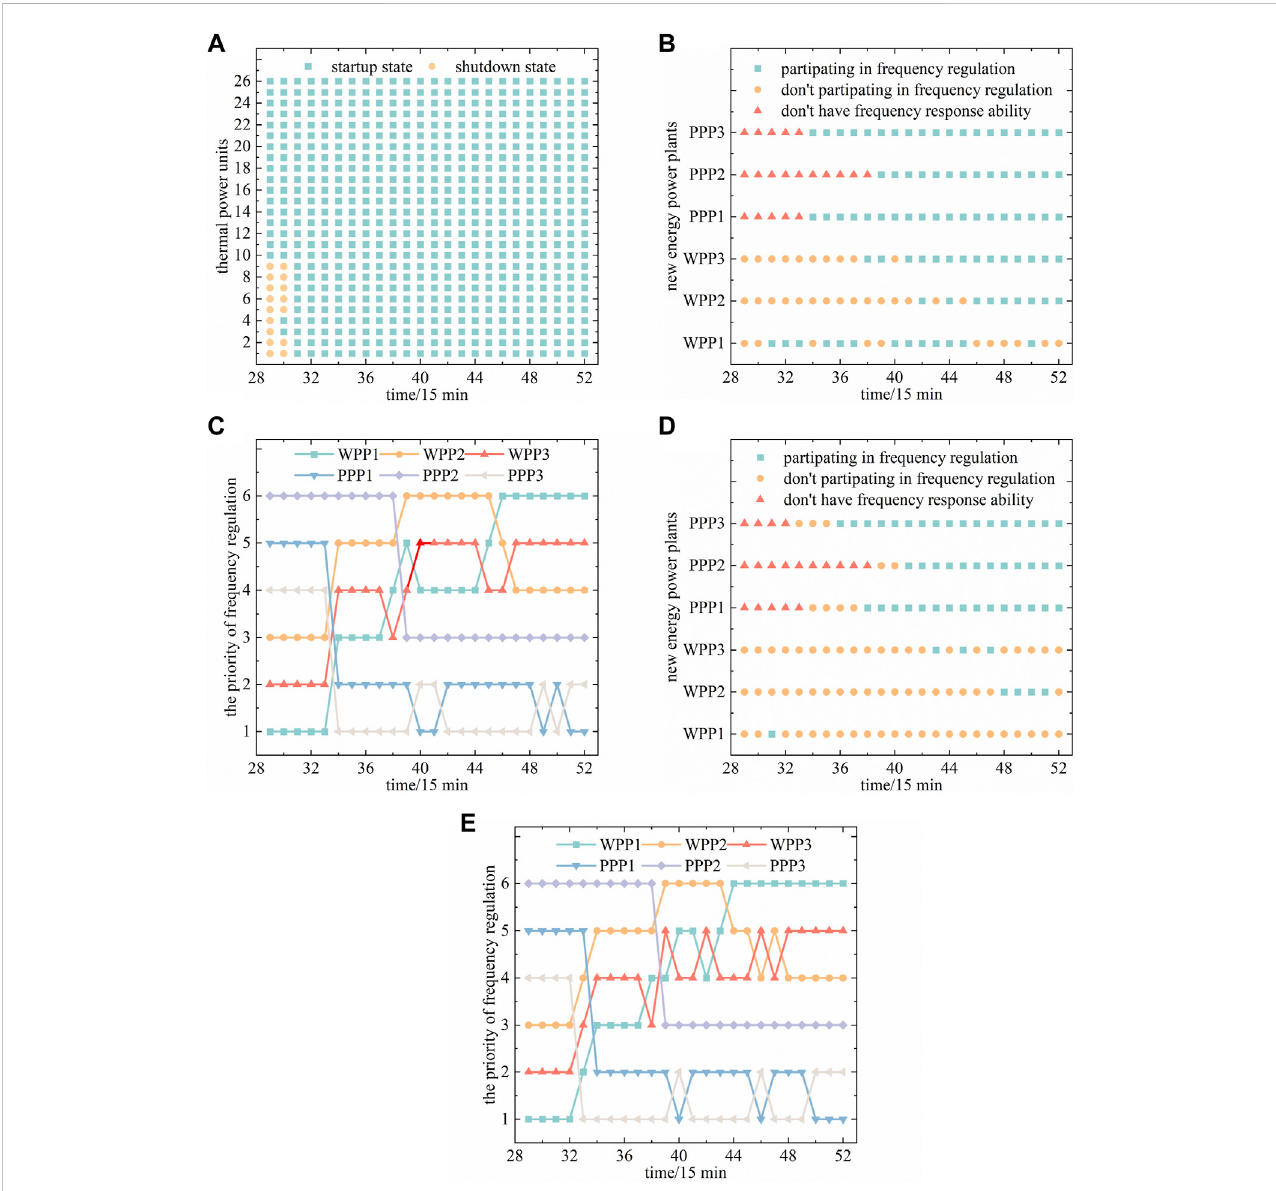
FIGURE 9 PSFR of the system in selected periods: (A) startup and shutdown states of thermal power units, (B) PSFR of NEPPs in day-ahead scheduling, (C) participation sequence of frequency regulation of NEPPs in day-ahead scheduling, (D) PSFR of NEPPs in intraday scheduling, and (E) participation sequence of frequency regulation of NEPPs in intraday